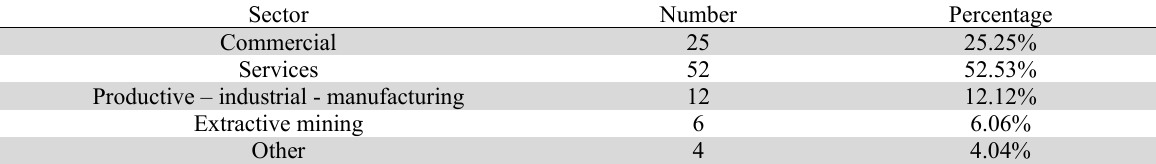
Sectorial distribution of the micro enterprises in the sample Sector